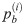
ChIP-seq simulation procedure.(A) Procedure overview. Each of n genomic regions contains a binding site with a binding energy ϵ(i) (in units of kB
T), where a lower value represents a higher affinity binding site. In the ChIP sample, the binding energy at the i-th location, and the chemical potential, set the probability of occupancy (pb(i)) of the target TF. The probability of occupancy determines the number of cells (out of a total of C cells) where the i-th location is bound. In Step 1 of the simulation, a total of Fe(i) fragments are extracted at the i-th location from a binomial distribution with mean Cpe(i). pe(i) is the extraction efficiency that represents the probability of successfully extracting a bound fragment. All of these fragments are unique (in red) since each fragment originates from a different cell. In Step 2, the extracted fragments are amplified through ncy cycles of PCR to give Fa(i) amplified fragments (duplicate fragments in black) with the probability of amplification of each fragment, or PCR efficiency, being pa(i) in every cycle. The average number of amplified fragments A obtained from each extracted fragment is A=(1+pa(i))ncy, which we refer to as the amplification ratio. In Step 3, ri reads are obtained from the i-th location after sampling r = cn fragments from all ∑i=1nFa(i) amplified fragments, where r is the total read count and c is the sequencing depth. The number of unique reads at each location is the final output of the simulation. For the control input sample, read counts are simulated as for the foreground ChIP sample, except that the probability of occupancy is assumed to be constant at all n locations and the number of cells is assumed to be 0.1C. (B) Sample output from the simulation. The top panel shows the distribution of binding energies employed in the simulation, which by default is a truncated power law between 0 and 10kB
T with an exponent of 0.5. The middle panel shows the number of unique reads from each genomic region in the ChIP (black) and input (gray) experiments. The bottom panel is the read count ratio between the ChIP and input samples at each location. The simulation parameters are n = 1000, μ = 3kB
T, ϵbg = 1kB
T, C = 105, ncy = 15, and A = 1000. The extraction efficiencies in the ChIP and input samples follow a truncated normal distribution between 0 and 1, with a mean of 0.5 and standard deviation of 0.05 across the genome.